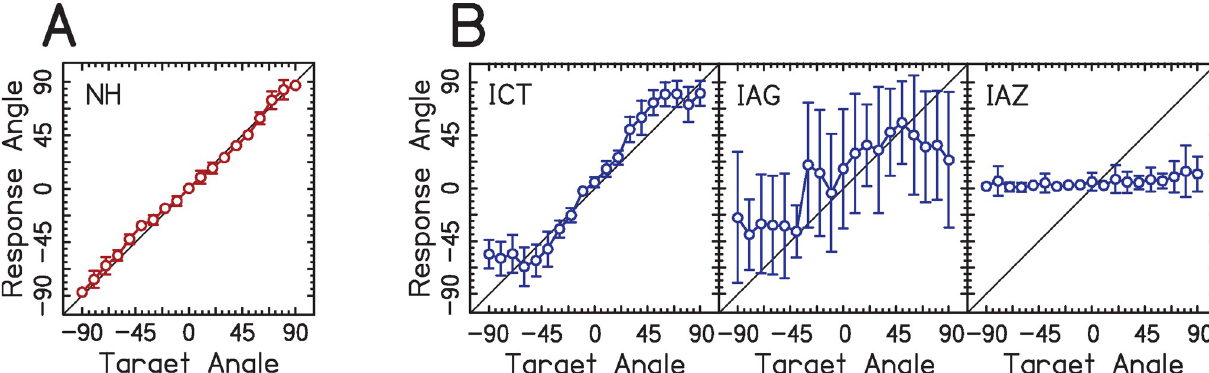
Fig 1. Example data from listeners with NH and BiCIs. The x-axis shows the angle from which the target speaker presented pink noise bursts. The y- axis shows the angle from which the listener perceived the sound. The diagonal shows perfect performance. Open circles represent mean response angles and error bars represent ± 1 standard deviation. (A) Data from one listener with NH. (B) Data from three listeners with BiCIs whose subject codes are given in the top-left portion of each panel. Listener IAG’s errors were driven by variability in their responses across all target speakers. Listener IAZ’s errors were driven by highly consistent biases toward the front/center speaker for lateral target